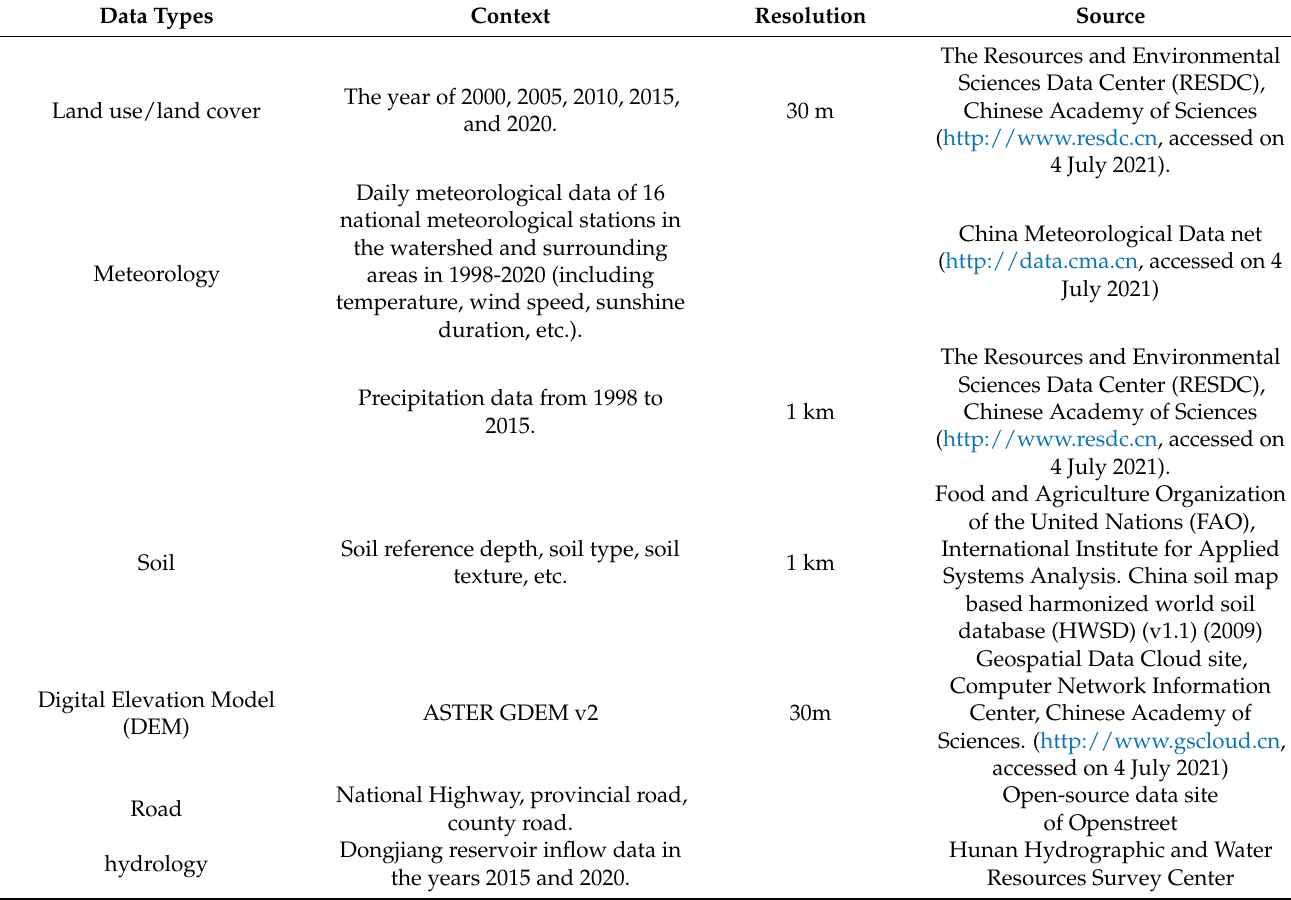
Table 1. Data types and